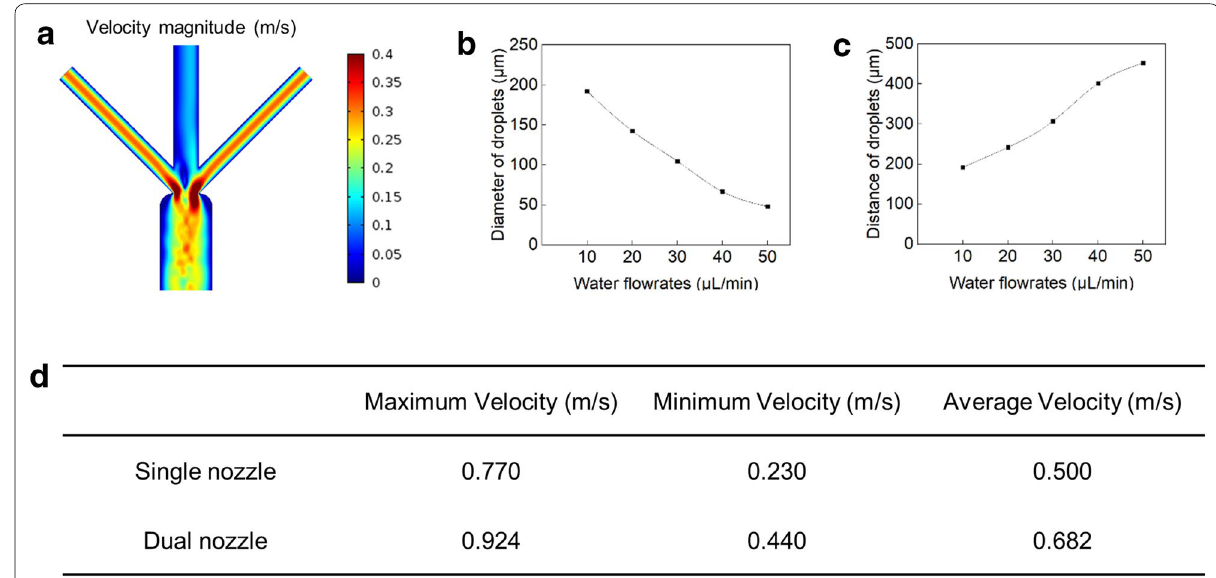
Fig. 3 Simulation of the second nozzle of the microfluidic device. Snapshot of the fluid velocity distribution around the second nozzle of the micro- fluidic device ( a ). Graphs of diameter of droplets generated at second nozzle against water flowrate ( b ). Graph of simulated distance of droplets after second nozzle as a function of water flow rate ( c ). Table of flow velocities for a single and dual-nozzle microfluidic device ( d